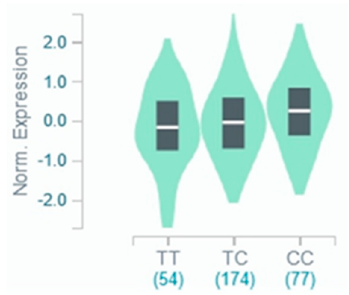
Figure 3. Effect of the common PRSS1-PRSS2 haplotype-tagging rs10273639C/T on PRSS2 mRNA expression in the pancreas. C is the risk allele. Data were obtained from the Genotype-Tissue Expression (GTEx) Portal.